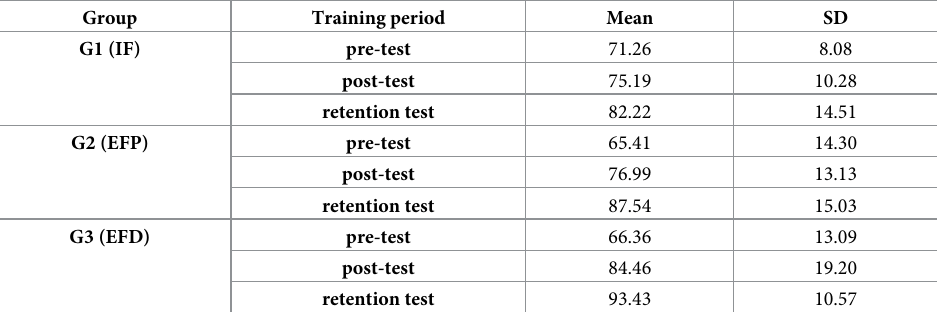
Table 1. Mean number of points (MNP) in G1, G2 and G3 during the two phases of the experimental design: Pre- acquisition and post-acquisition.